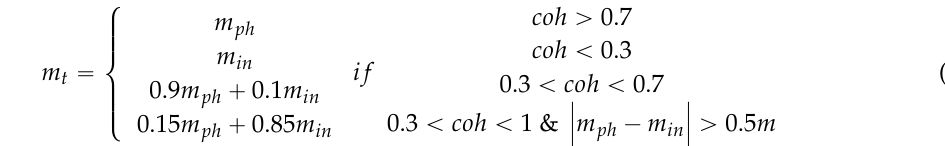
Figure 4. Results of D ‐ InSAR, MAI, and PT during the temporal period of 23 December 2008–28 January 2009. ( a ) D ‐ InSAR unwrapping result; ( b ) PT result in the LOS direction; ( c ) MAI unwrapping result; and ( d ) PT result in the along ‐ track direction.